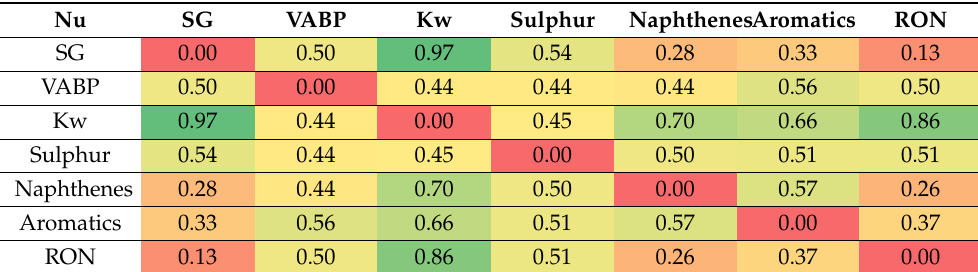
Table 9. υ -values of the Intercriteria analysis evaluation of relations between properties of naphtha fractions derived from 244 different crude